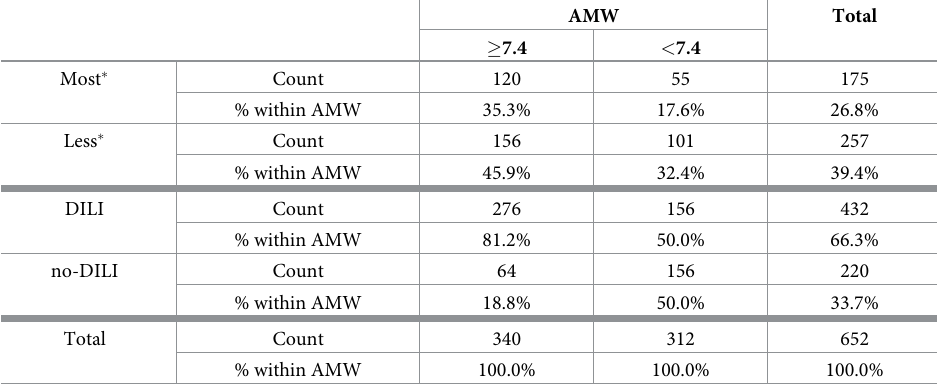
Table 3. Contingency table between DILI/no-DILI and AMW.